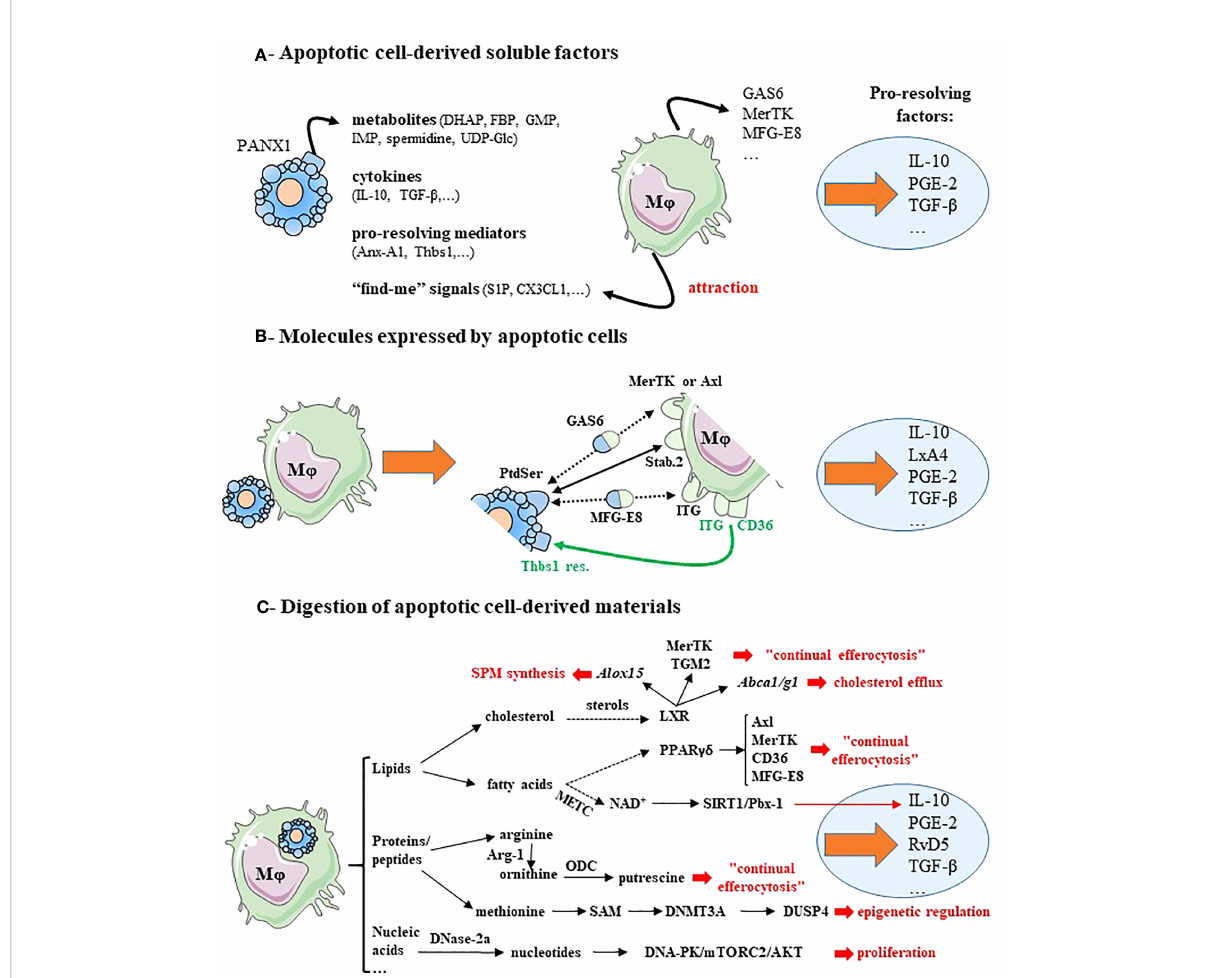
FIGURE 1 Macrophage reprogramming after efferocytosis may result from apoptotic cell-derived factors, surface molecules expressed by apoptotic cells or metabolites generated by apoptotic cell digestion. (A) Soluble factors released by apoptotic cells induce pro-resolving macrophage reprogramming and lead to pro-resolving factor secretion. Apoptotic cells release four kind of factors: cellular metabolites via the Pannexin-1 channels (PANX1), anti-in fl ammatory cytokines, pro-resolving mediators and “ fi nd-me ” signals. These “ fi nd-me ” signals affect tissue-resident macrophages locally, and diffuse to target monocyte-derived macrophages and attract them. These mediators stimulate the expression of efferocytic receptors (MerTK) and opsonins (e.g., GAS6 or MFG-E8). (B) Molecules expressed by cells becoming apoptotic promote macrophage reprogramming and induce the synthesis of pro-resolving factors. This is illustrated by the expression of the chief “ eat-me ” signal phosphatidylserine (PtdSer) that interacts directly with efferocytic receptors (e.g., Stabilin-2 [Stab.2]), or indirectly via bi-functional opsonins (e.g., GAS6 or MFG-E8) and with the efferocytic receptors MerTK or integrin receptors (ITG)(black lines). CD36 in association with integrin receptors (ITG, ITGB3 or ITGA5) recognizes thrombospondin-1 residues (Thbs1 res.) at the apoptotic cell surface (green lines). (C) Cellular metabolites resulting from apoptotic cell-derived materials stimulate macrophage reprogramming and the secretion of pro-resolving factors. In addition, these metabolites trigger several signaling pathways, implicated in ef fi cient reprogramming including: macrophage proliferation, epigenetic regulation, continual efferocytosis, cholesterol ef fl ux and specialized pro-resolving lipid mediator (SPM) synthesis (text in red font). Dotted arrows correspond to a suspected and indirect link. Pro-resolving factors are identi fi ed by light blue circles. Gene names are written in italics. For more details, please see the text. Abbreviations: ABC, ATP-binding cassette transporters; Alox15, arachidonate 15-lipoxygenase; Anx-A1, annexin-A1; Arg-1, arginase-1; CX3CL1, fractalkine; DHAP, dihydroxyacetone phosphate; DNA-PK, DNA-dependent protein kinase; DNase-2a, deoxyribonuclease-2a; DNMT3A, DNA methyltransferase-3A; DUSP4, dual-speci fi c phosphatase 4; FBP, fructose-1,6-biphosphate; GAS6, growth arrest-speci fi c protein 6; GMP, guanosine-5 ′ -monophosphate; IMP, inosine-5 ′ -monophosphate; ITG, integrin receptors;, LxA4,